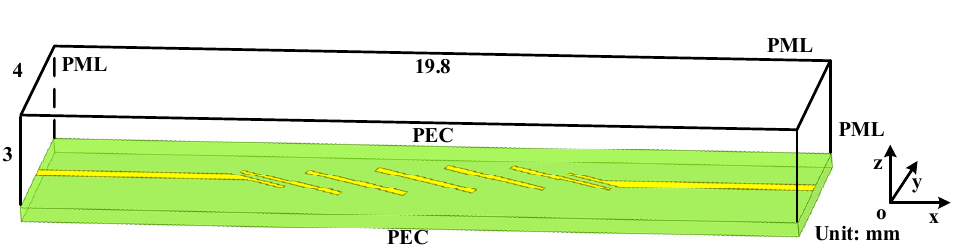
Figure 3. The sketch picture of the entire filter computational domain.